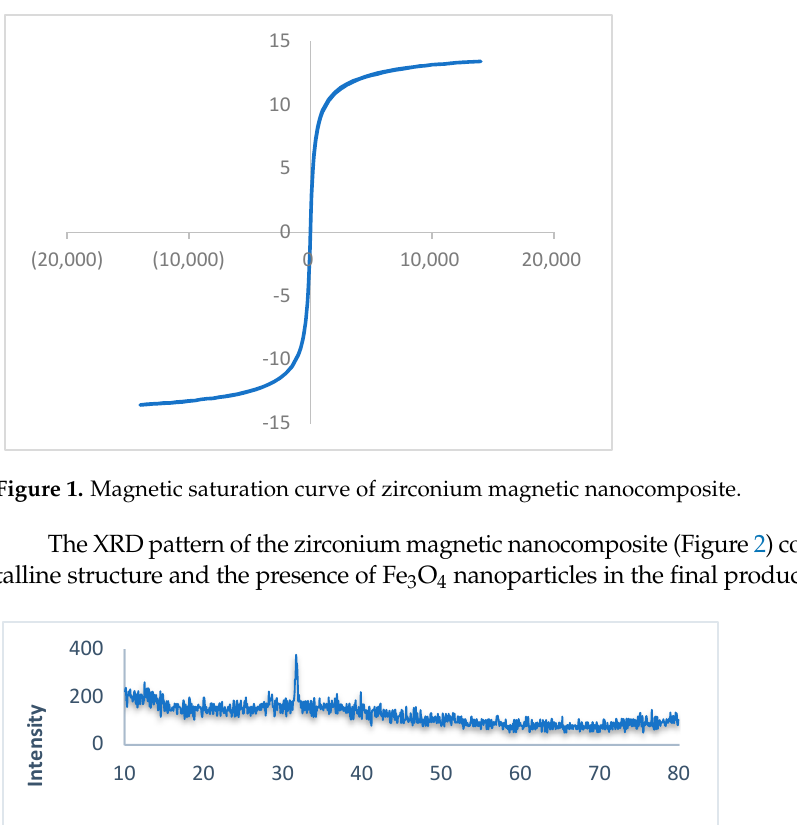
Figure 2. X-ray diffraction pattern of zirconium magnetic nanocomposite.